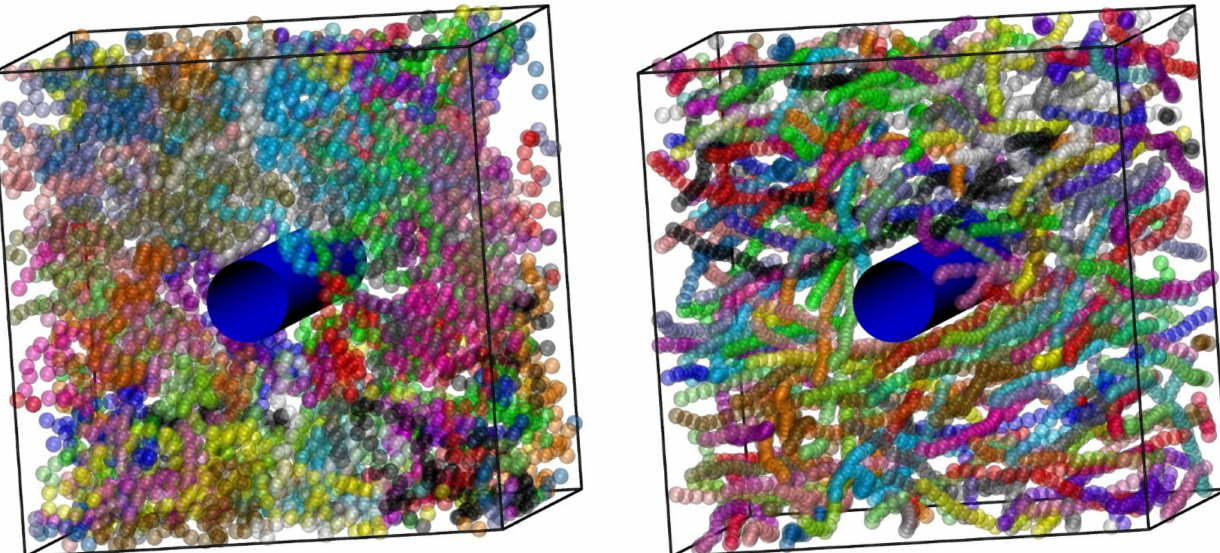
Figure 13. System snapshots of polymer nanocomposite ( N = 100, N ch = 48, ϕ eff = 0.10). The nanofiller, shown in blue, corresponds to a single, impenetrable cylinder with diameter d cyl = 5 (in units of σ ) and infinite length. The cylinder is oriented along the direction of one of the cell axes. ( left ) Freely jointed chains and ( right ) semi-flexible, rod-like chains ( θ 0 = 0 ◦ ). Monomers are colored according to the parent chain and are shown as semitransparent spheres for clarity. Image created with the VMD visualization software [54]. Figure panels are also available as interactive, 3-D images in Supplementary